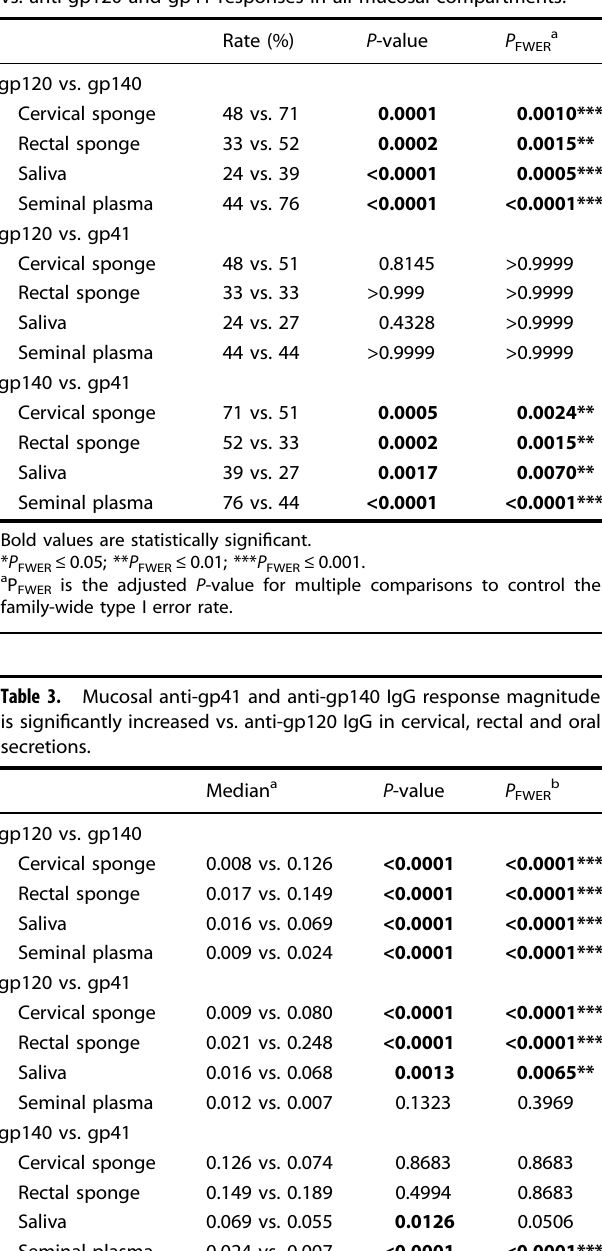
Table 2. Mucosal anti-gp140 response rates are signi fi cantly increased vs. anti-gp120 and gp41 responses in all mucosal compartments.